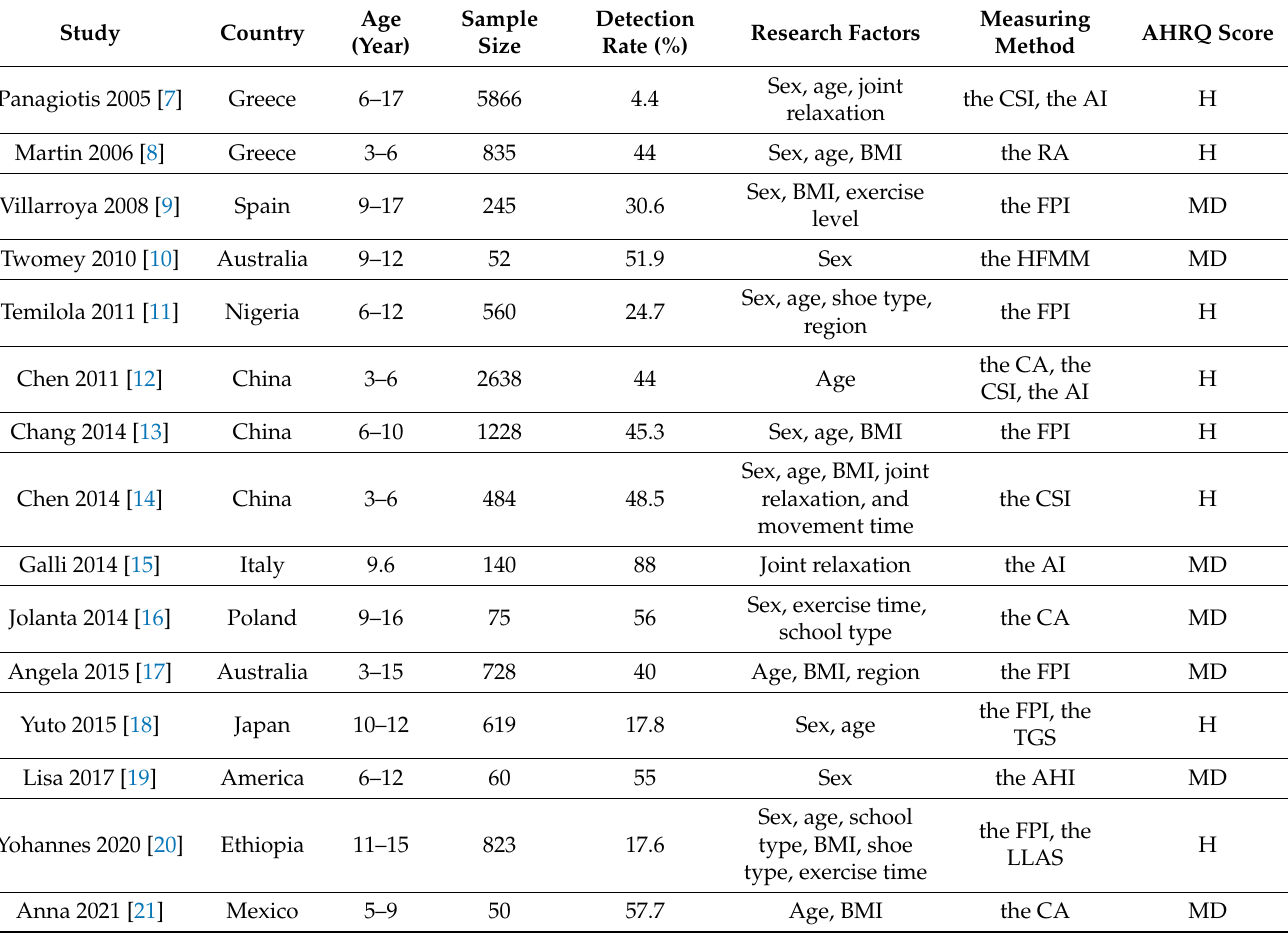
Table 1. The general characteristics of the studies